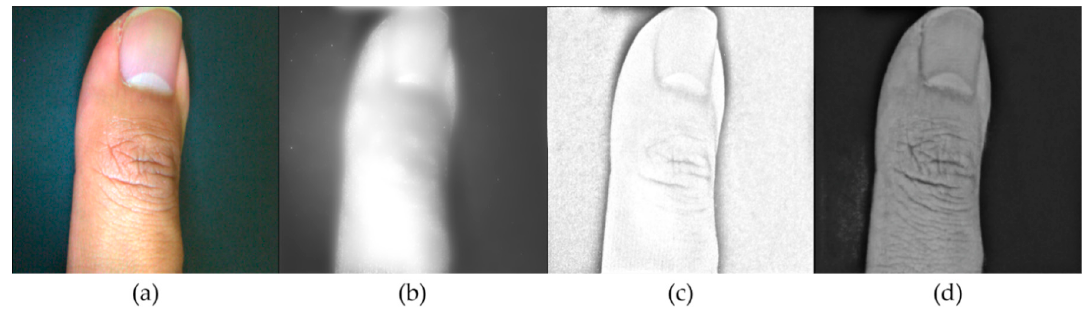
Figure 5. The decomposed images acquired by applying intrinsic decomposition method proposed by [35]: ( a ) shows original center images with directional illumination; ( b , c ) represent illumination image and reflectance image, respectively; ( d ) is the final refined results acquired by merging the output from CGAN model and the reflectance image.